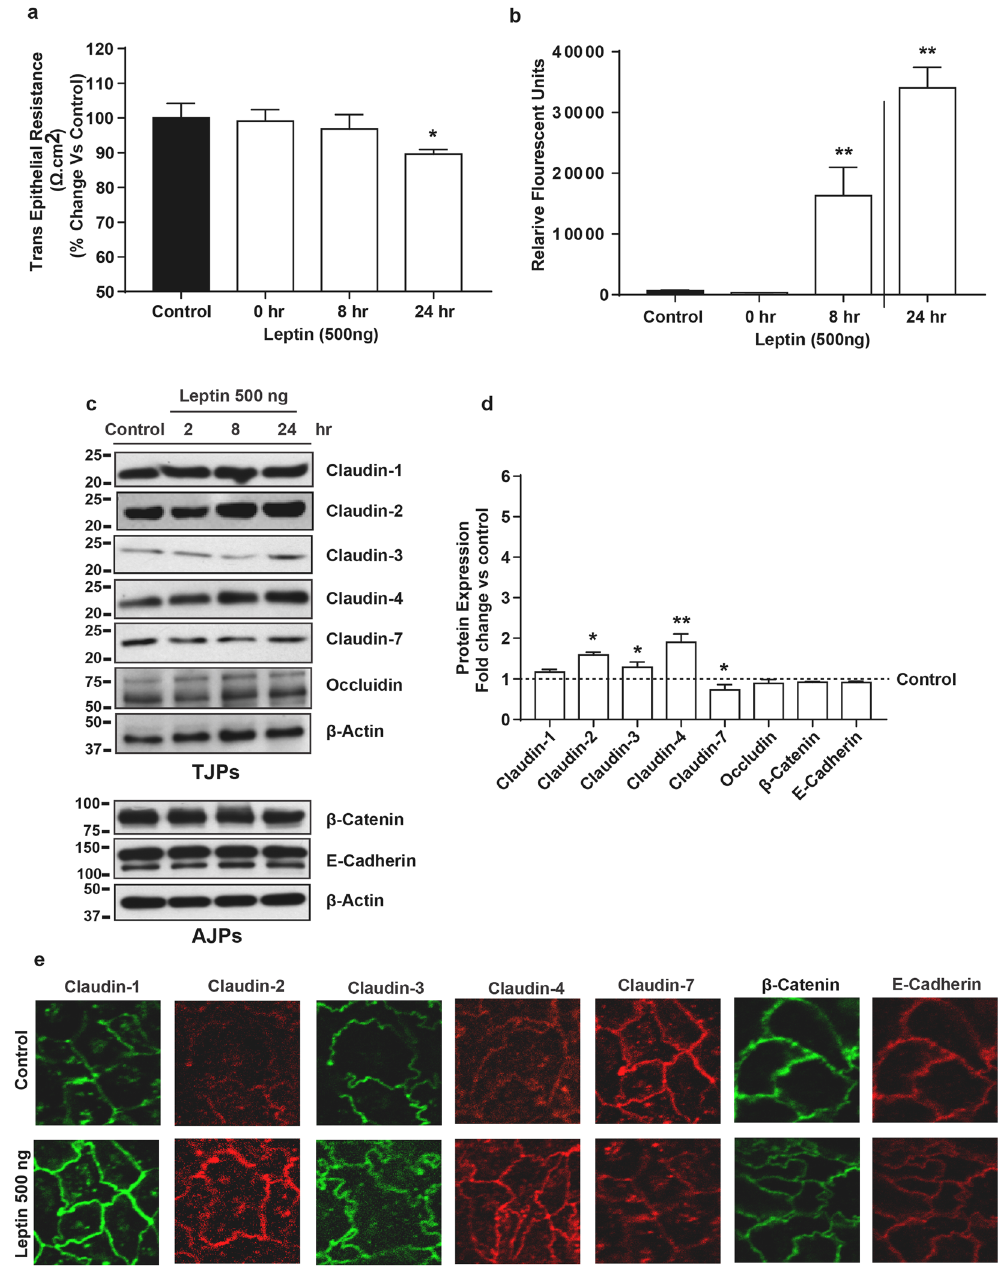
Figure 6. Leptin induced changes in intestinal epithelial barrier function are dependent on differential restructuring of tight junction than DCA-treatment. Polarized monolayer of Caco-2 cells was subjected to Leptin (500 ng)-treatment (in complete culture medium) for different time-points . ( a ) Effect of leptin-treatment upon trans-epithelial resistance across the cell monolayer; ( b ) Apico-basal paracellular permeability in control or leptin-treated cells as described in “materials and methods”. ( c ) Immunoblots analysis of total cell lysate from control and leptin treated cells by using antigen-specific antibodies; ( d ) Quantitative analysis of the antigen specific band intensity from immunoblot analysis; ( e ) Representative confocal immunoflurescent imaging to determine cellular localization of cell-adhesion proteins (TJPs and AJPs) in control and leptin-treated cells. Values are presented as mean ± SEM. ** P ≤ 0.01 and * P ≤ 0.05 compared to